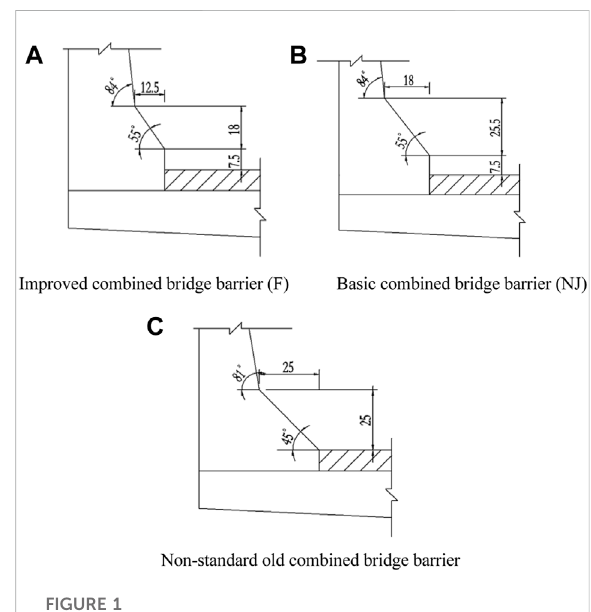
FIGURE 1 Collision surface of combined bridge barriers. (A)